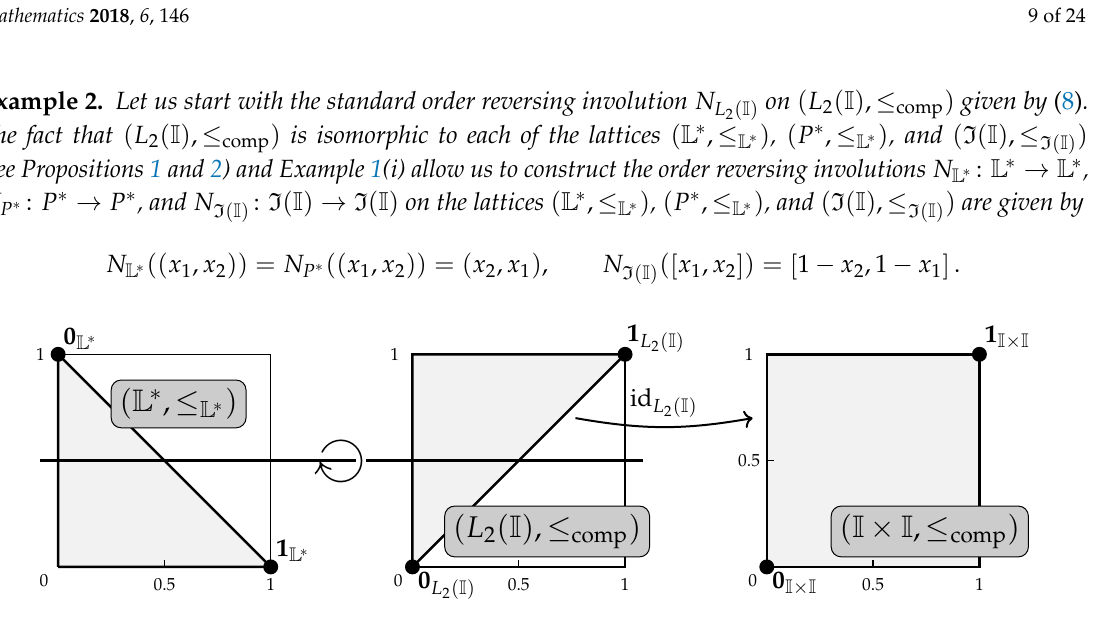
) ( right ). The I , × ≤ comp ) are isomorphic, ≤ comp